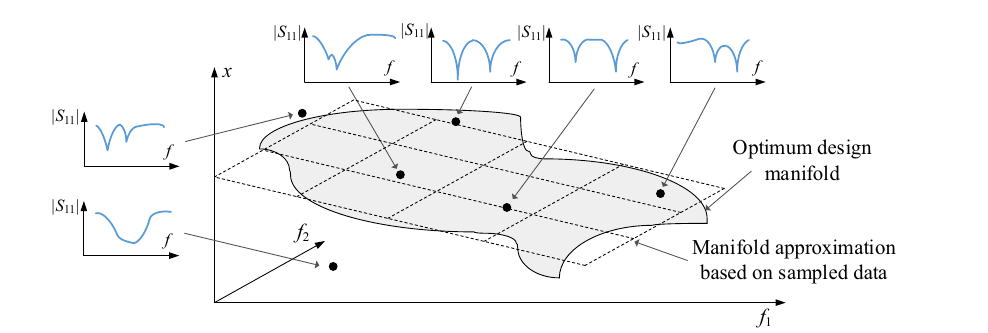
Figure 3. Conceptual illustration of the use of response features for identification of the promising regions of the parameter space. Shown are: optimum design manifold (here, demonstrated for a dual-band antenna optimized with respect to two operating frequencies f 1 and f 2 ), the vertical axis being one of antenna geometry parameters; black circles corresponding to random observables with their response features (here, antenna resonance allocation) extracted. Note that the observables are not optimized, therefore, they are generally away from the optimum design manifold; however, they can still be used to produce a rough approximation of the manifold by associating the response features with the objective space of f 1 and f 2 (cf. “Identification of promising regions by inverse regression models”